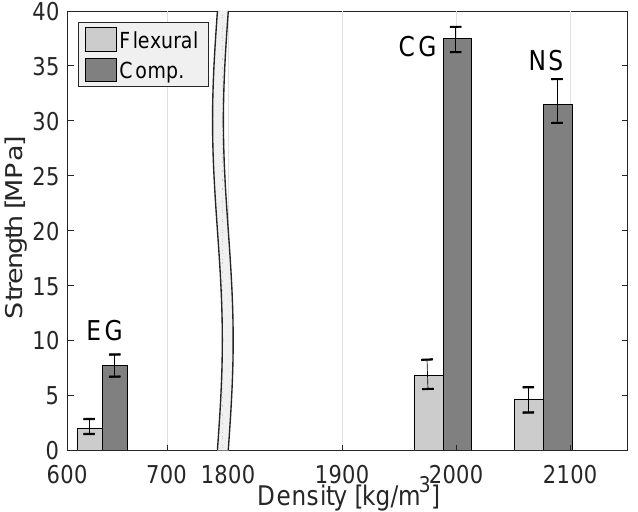
Figure 6. Compressive and flexural strengths of the specimens with different